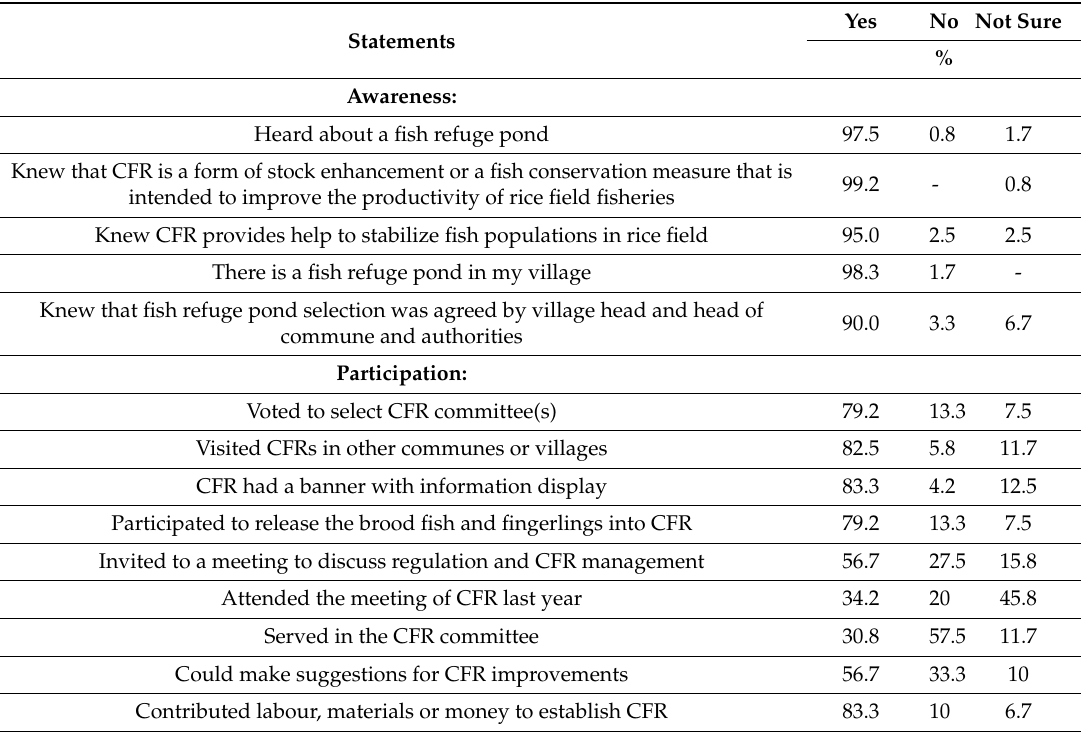
Table 4. Beneficiaries’ knowledge of and participation in CFR management ( N = 120).